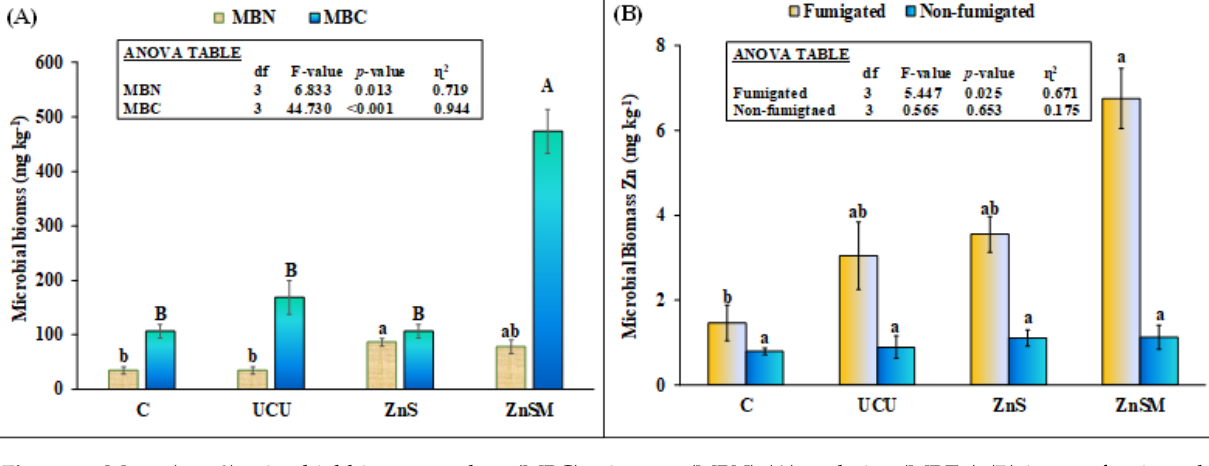
Figure 6. Mean ( n = 3) microbial biomass carbon (MBC), nitrogen (MBN) ( A ) and zinc (MBZn) ( B ) in non-fumigated and fumigated soil after application of uncoated (UCU) and coated urea with zinc sulphate (ZnS) and zinc sulphate plus molasses (ZnSM). C represents untreated control. Error bars showed standard errors of the mean. Different small and capital letters show significant differences among treatments at 5% probability level. Inset in figure represents ANOVA Table. Multiple comparisons among treatments were analyzed by Tukey’s HSD test. Table 1. Mean ( n = 3, ±1 SE) growth and yield parameters of sunflower crop as influenced by uncoated urea (UCU), coated urea with zinc sulfate (ZnS) and zinc sulfate plus molasses (ZnSM). C stands for untreated control. Different small letters within a column indicates the significant difference among treatments at 5% probability level after Tukey HSD test.